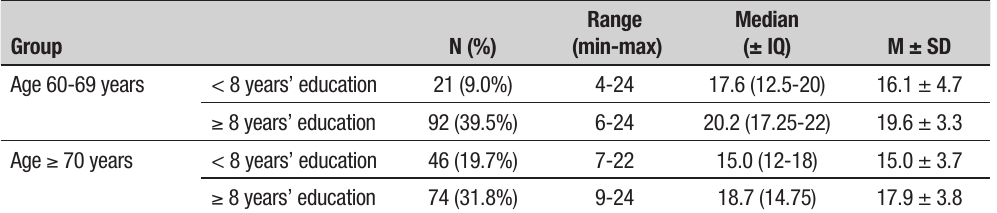
Table 3. Distribution of RBMT values according to age group and schooling in 233 elderly without cognitive decline.